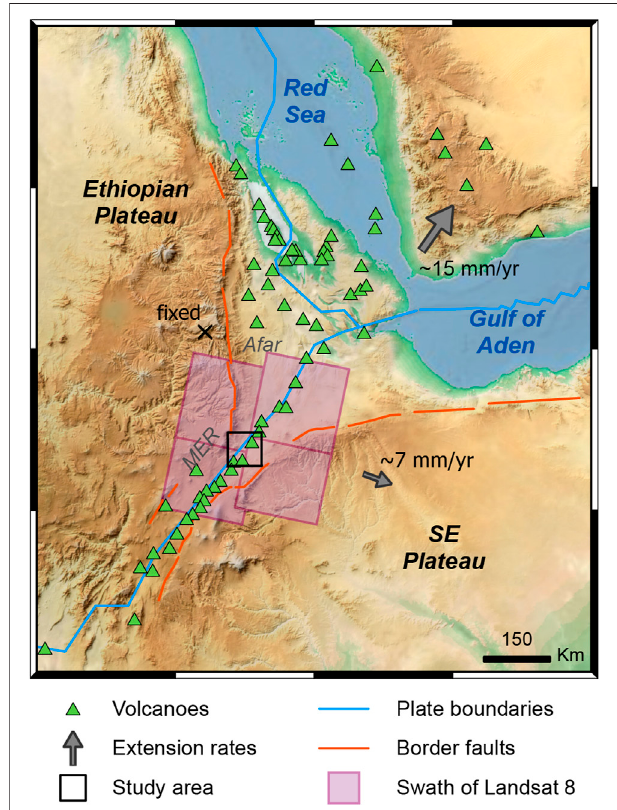
FIGURE1| TectonicsettingoftheEastAfricanRift.Solidbluelinesshow the plate boundaries while solid red line show Oligocene – Miocene border faults. The green triangles are the Holocene volcanoes, pink squares are the footprint of Landsat 8 images and black square is the study area. The arrows show the motion of the Arabian Plate and the Somalian Plate respect to fi xed Nubian